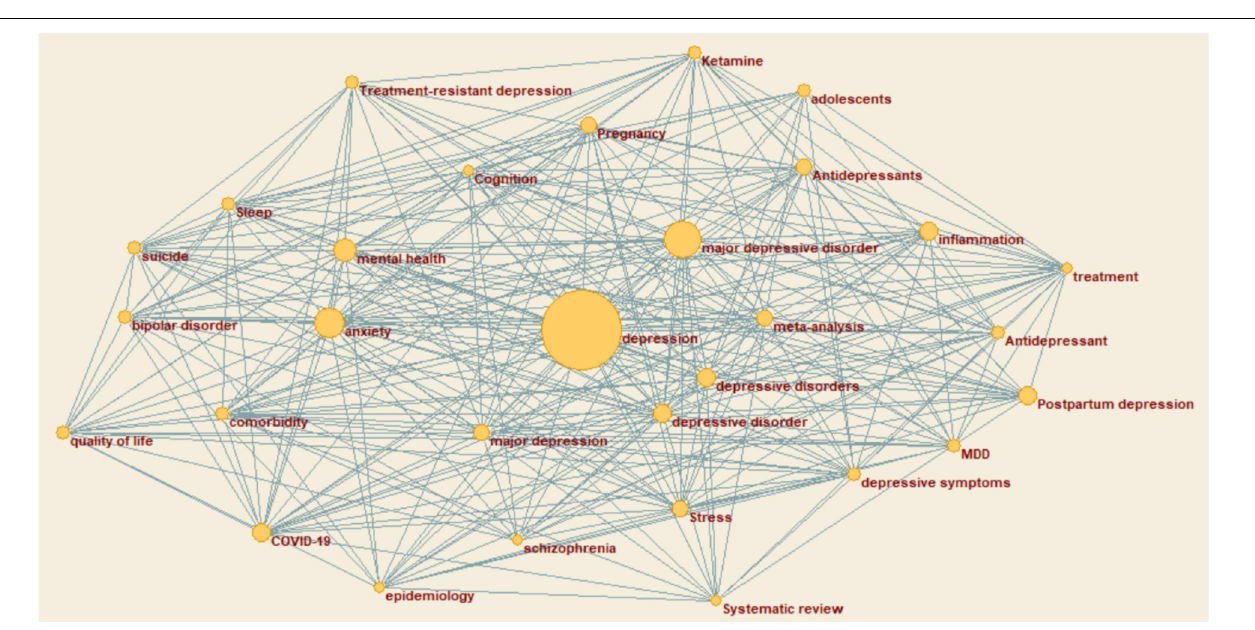
FIGURE 3 | Pajek analyzes the results of network files and vector